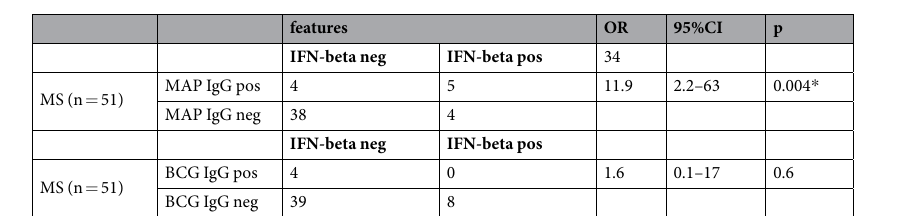
Table 2. Relationship between mycobacterial IgG positivity and interferon-beta (IFN) therapy. MS, multiple sclerosis; NMOSD, neuromyelitis optica spectrum disorders; OR, odds ratio; CI, confidence interval; * statistically